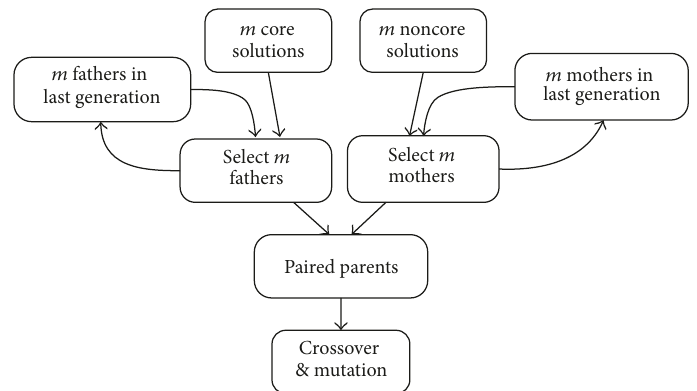
Figure 6: Process of the genetic